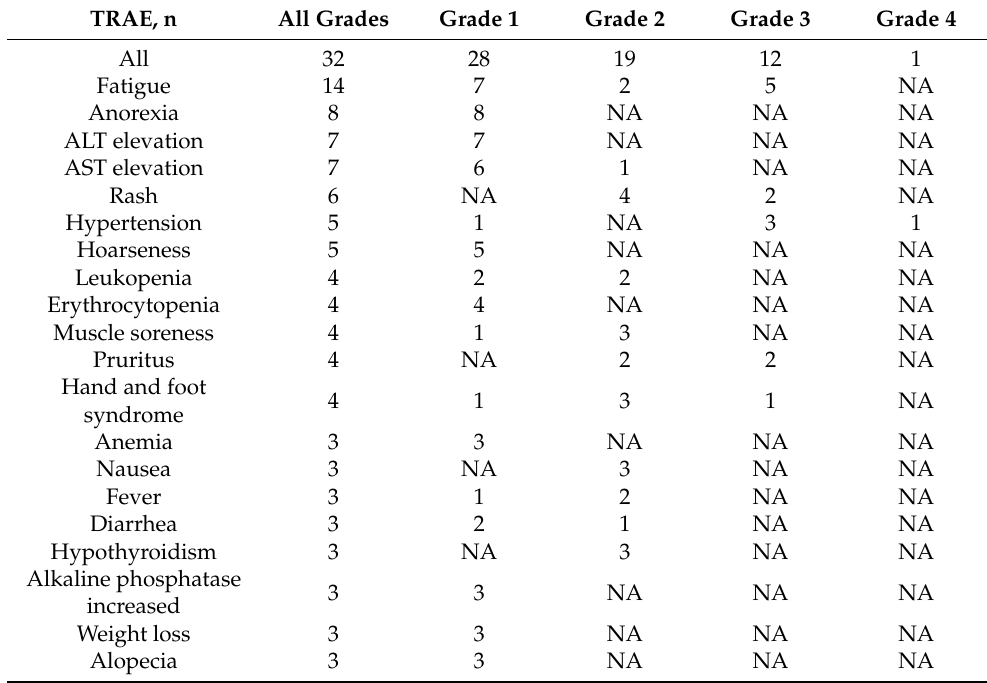
Table 9. Treatment-related adverse event of combined therapies. TRAE, n All